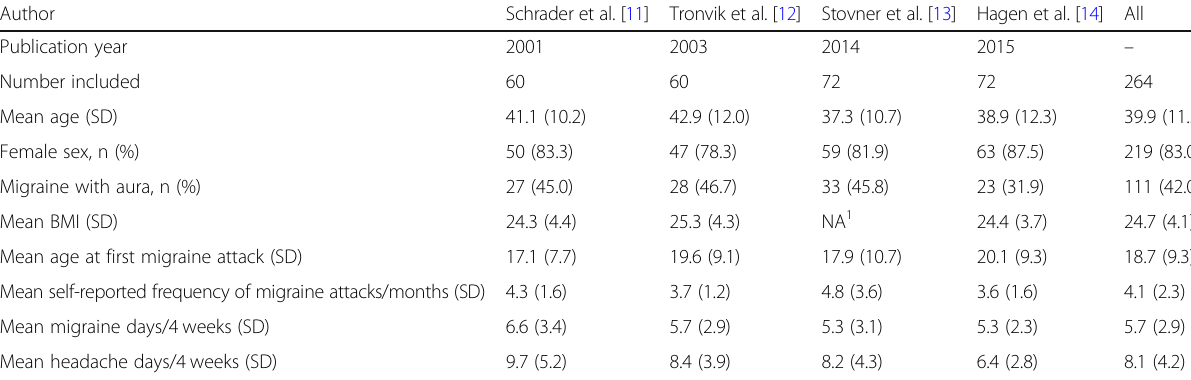
Table 2 Background variables in the different